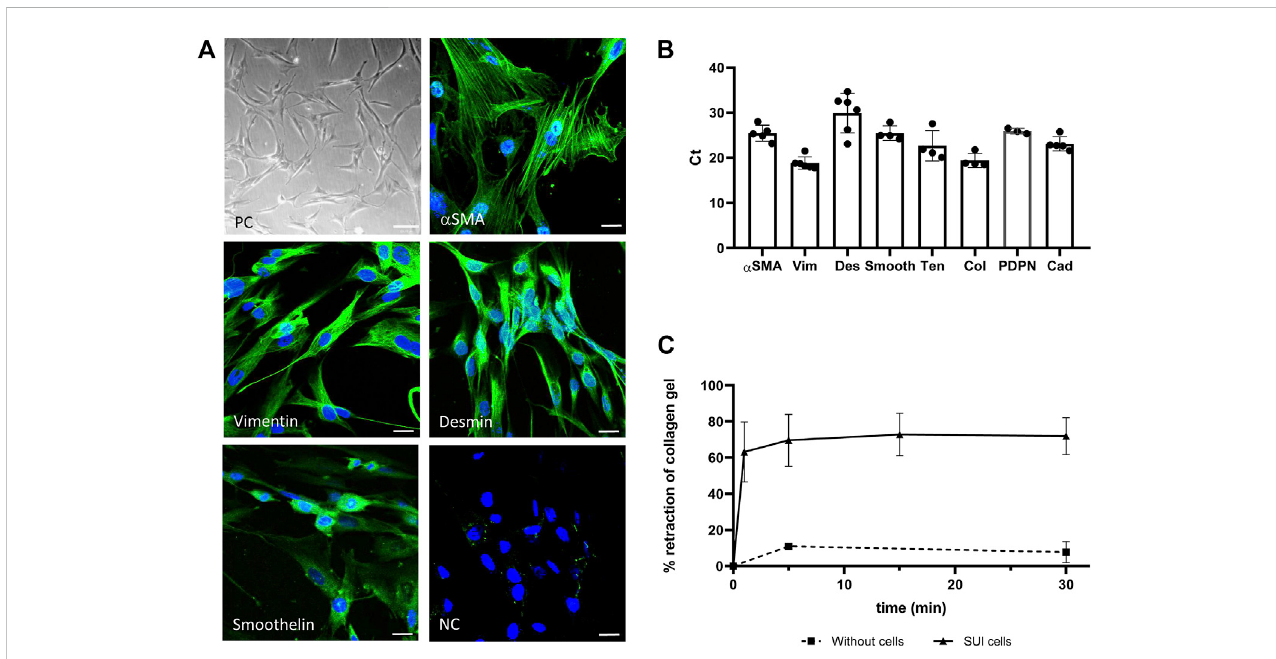
FIGURE 3 Characterization of primary suburethral myo fi broblasts cultures. (A) Representative photomicrograph of suburethral myo fi broblasts isolated from SUI patients.Cellsare fi broblast-shapedasshowninphasecontrast(PC)panelandexpressseveralmarkersofmyo fi broblast,suchus α -SMA,vimentin,desminand smoothelin (in green) as shown in confocal microscopy images. NC is the negative control of immuno fl uorescence. Bar = 100 μ m in PC panel and 22 μ m in immuno fl uorescence panels. (B) Gene expression of myo fi broblast markers was determined by real-time qPCR. The analyzed cells correspond to passage 3. Data are presented as mean ± standard deviation (SD). Gene abbreviations: α -SMA, alpha smooth muscle actin; Vim, vimentin; Des, desmin; Smooth, smoothelin; Ten, tenascin; Col, collagen I, PDPN, podoplanin; Cad, Cadherin. (C) Retraction of a collagen lattice by suburethral myo fi broblasts. Evolutionofthediameterofcollagengelsurfaceincubatedwithsuburethralmyo fi broblasts(triangles)orwithoutcells(squares)oncethegelisdetachedfrom theedgesoftheculturewells.Dataiscalculatedastheareaofthewellthatisnotoccupiedbythecollagengelafterdetachmentrespecttothetotalareaofthe well, and expressed as